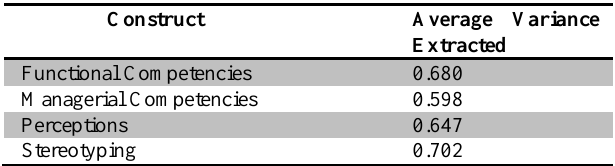
Table 2: Convergent and discriminant validity